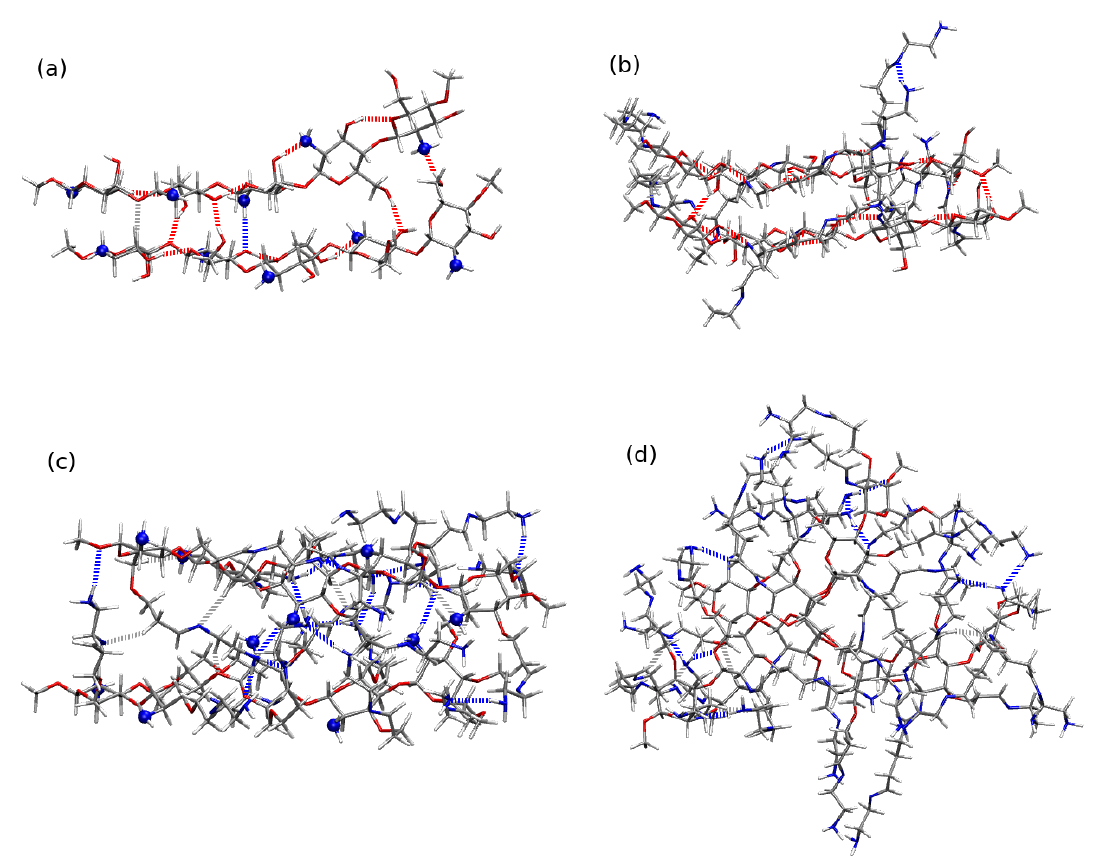
(cid:2) (cid:3) (cid:2) (cid:3) CS 5 CS 5 ( NH 2 ) , ( b ) , 2 2